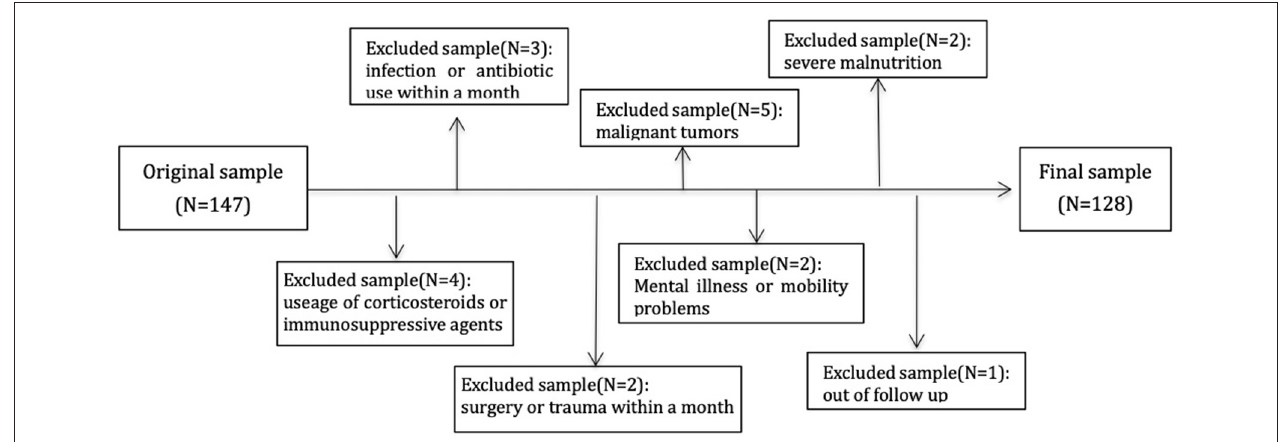
FIGURE 1 | Flowchart describing sample selection. One hundred and forty-seven individual subjects were enrolled and excluded 19 subjects with different reasons. A total of 128 cases were in